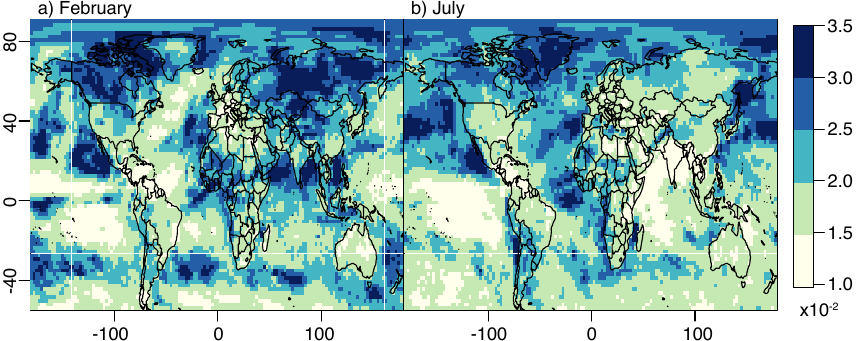
Figure 6. The coefficient of variation (CV, unitless) for the monthly-averaged model surface layer. The results plotted here are for the synthetic tracer simulation (Sects. 2.5, 3.4). In that simulation, the synthetic fluxes have a constant spatial distribution. The resulting CV ( σ /µ ) shows the distribution of month-long, surface-level transport uncertainties independent of the spatial distribution in the